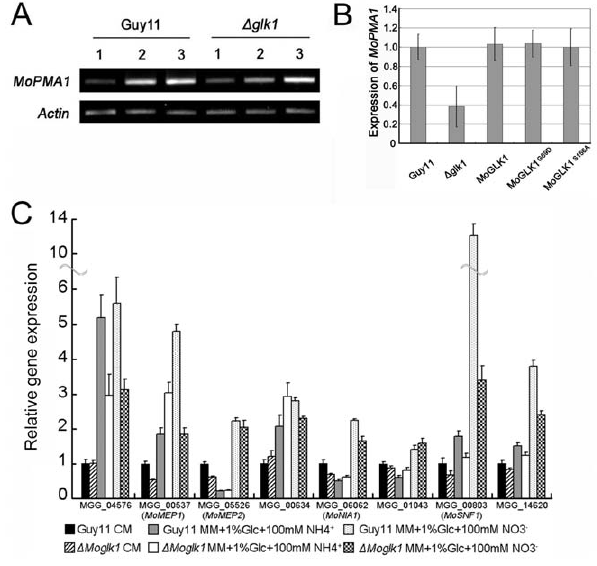
Figure 5. Gene expression analysis from Guy11 and D Moglk1 mutants. (A) Expression levels of the MoPMA1 gene in indicated conditions by semi-quantitative RT-PCR, using ACTIN as control. 1, MM + 1% glucose + 100 mM nitrate; 2, MM + 1% glucose + 100 mM ammo- nium; 3, MM + 5% glucose + 100 mM ammonium. (B) Relative transcript abundance of MoPMA1 of Guy11 and D Moglk1 mutant and D Moglk1 mutants transformed with wild-type MoGLK1 , MoGLK1 G69D and MoGLK1 S156A grown in MM with 1% glucose and 100 mM ammonium for 3 days. Each profile was normalized against ACTIN and compared relative to the expression of MoPMA1 in Guy11. (C) qRT-PCR analysis of gene expression from Guy11 and D Moglk1 mutant grown for 36 h in CM liquid medium and MM liquid medium containing either 100 mM ammonium or 100 mM nitrate as the sole nitrogen source. Gene transcript levels were normalized to the level of ACTIN and compared relative to the expression of each gene in Guy11 grown in CM. Error bars indicate standard deviations from the mean. Two independent biological repeats were performed and three technical replicates of each repeat were